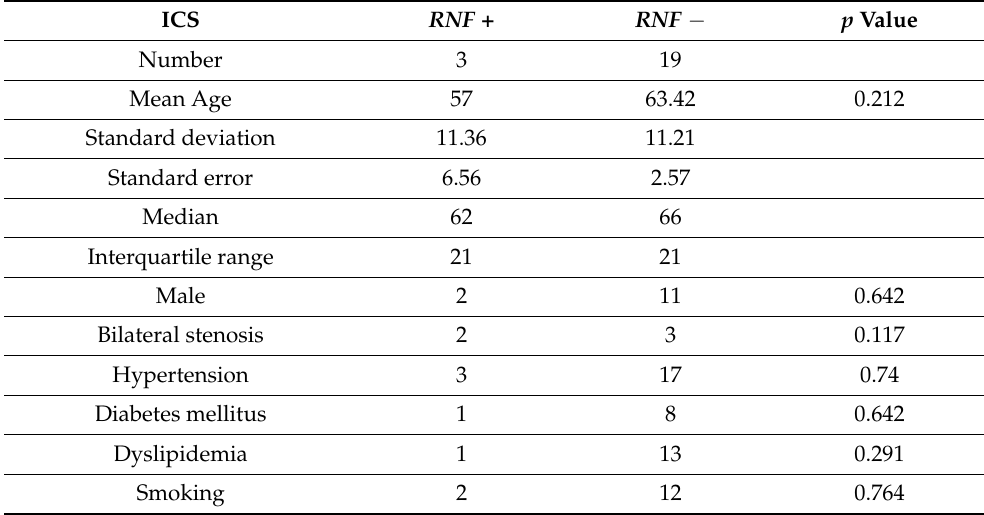
Table 4. Characteristics of cases with and without RNF213 (c.14576G>A) in the internal carotid artery stenosis